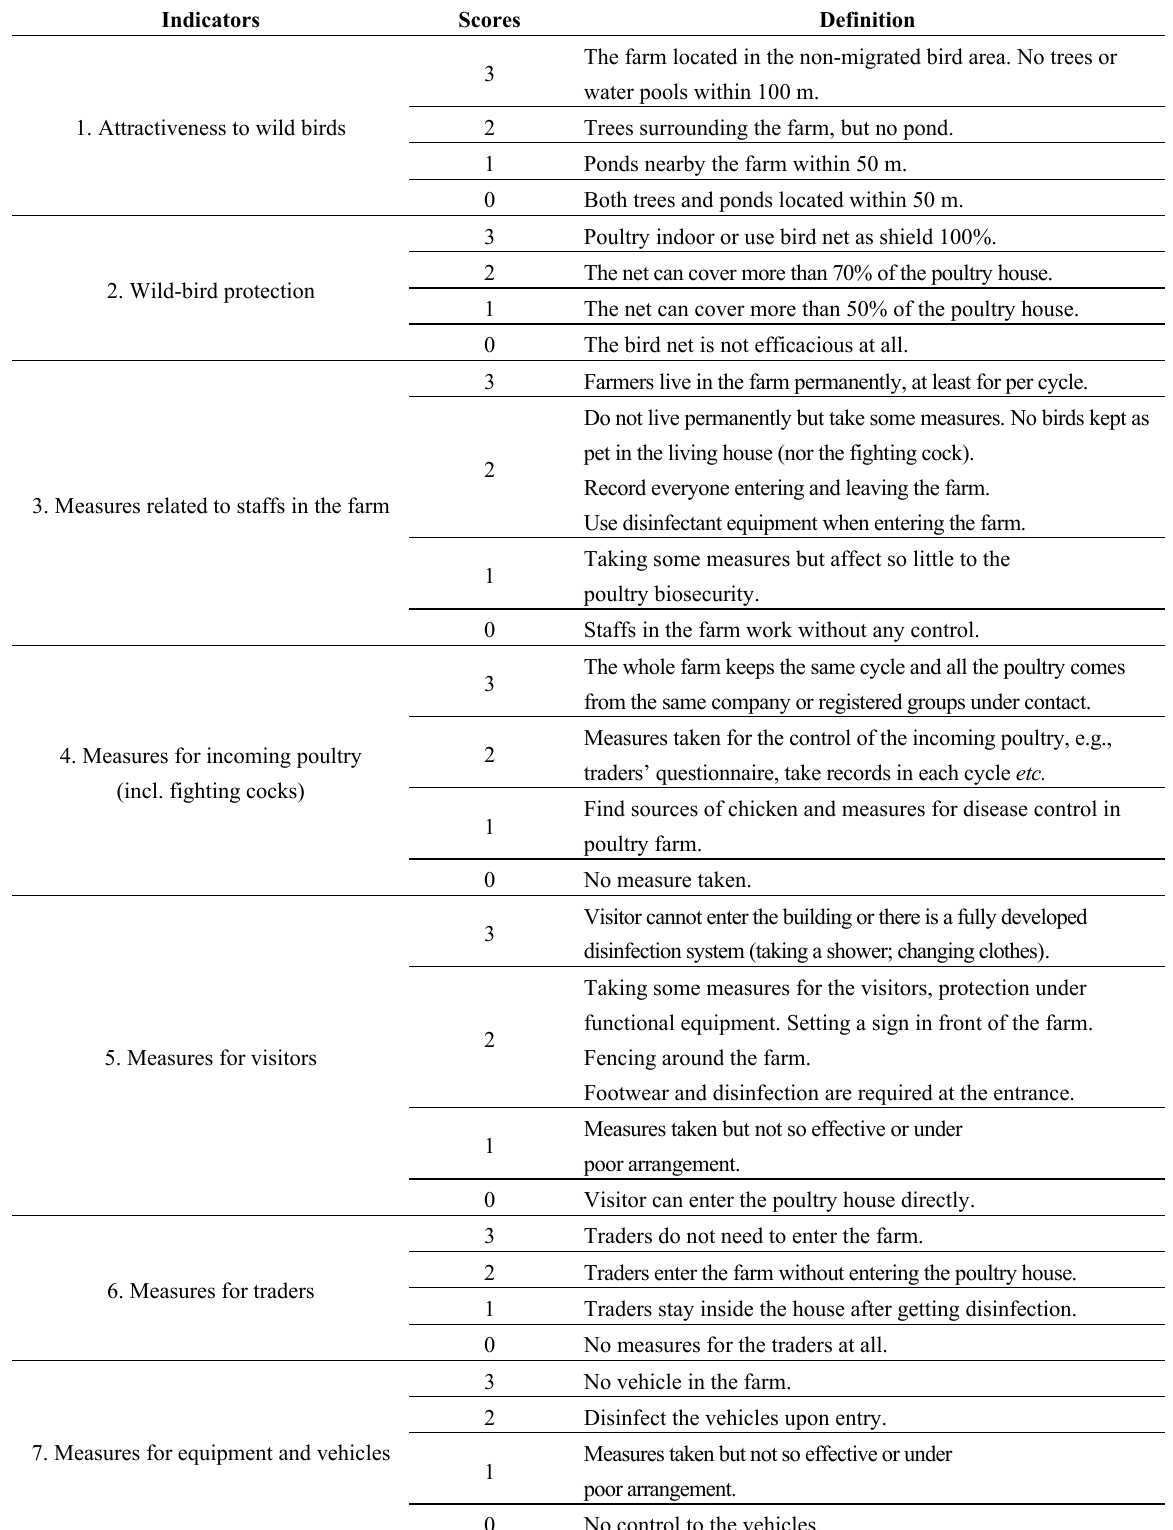
Table 2. Indicators and definition of biosecurity score in each